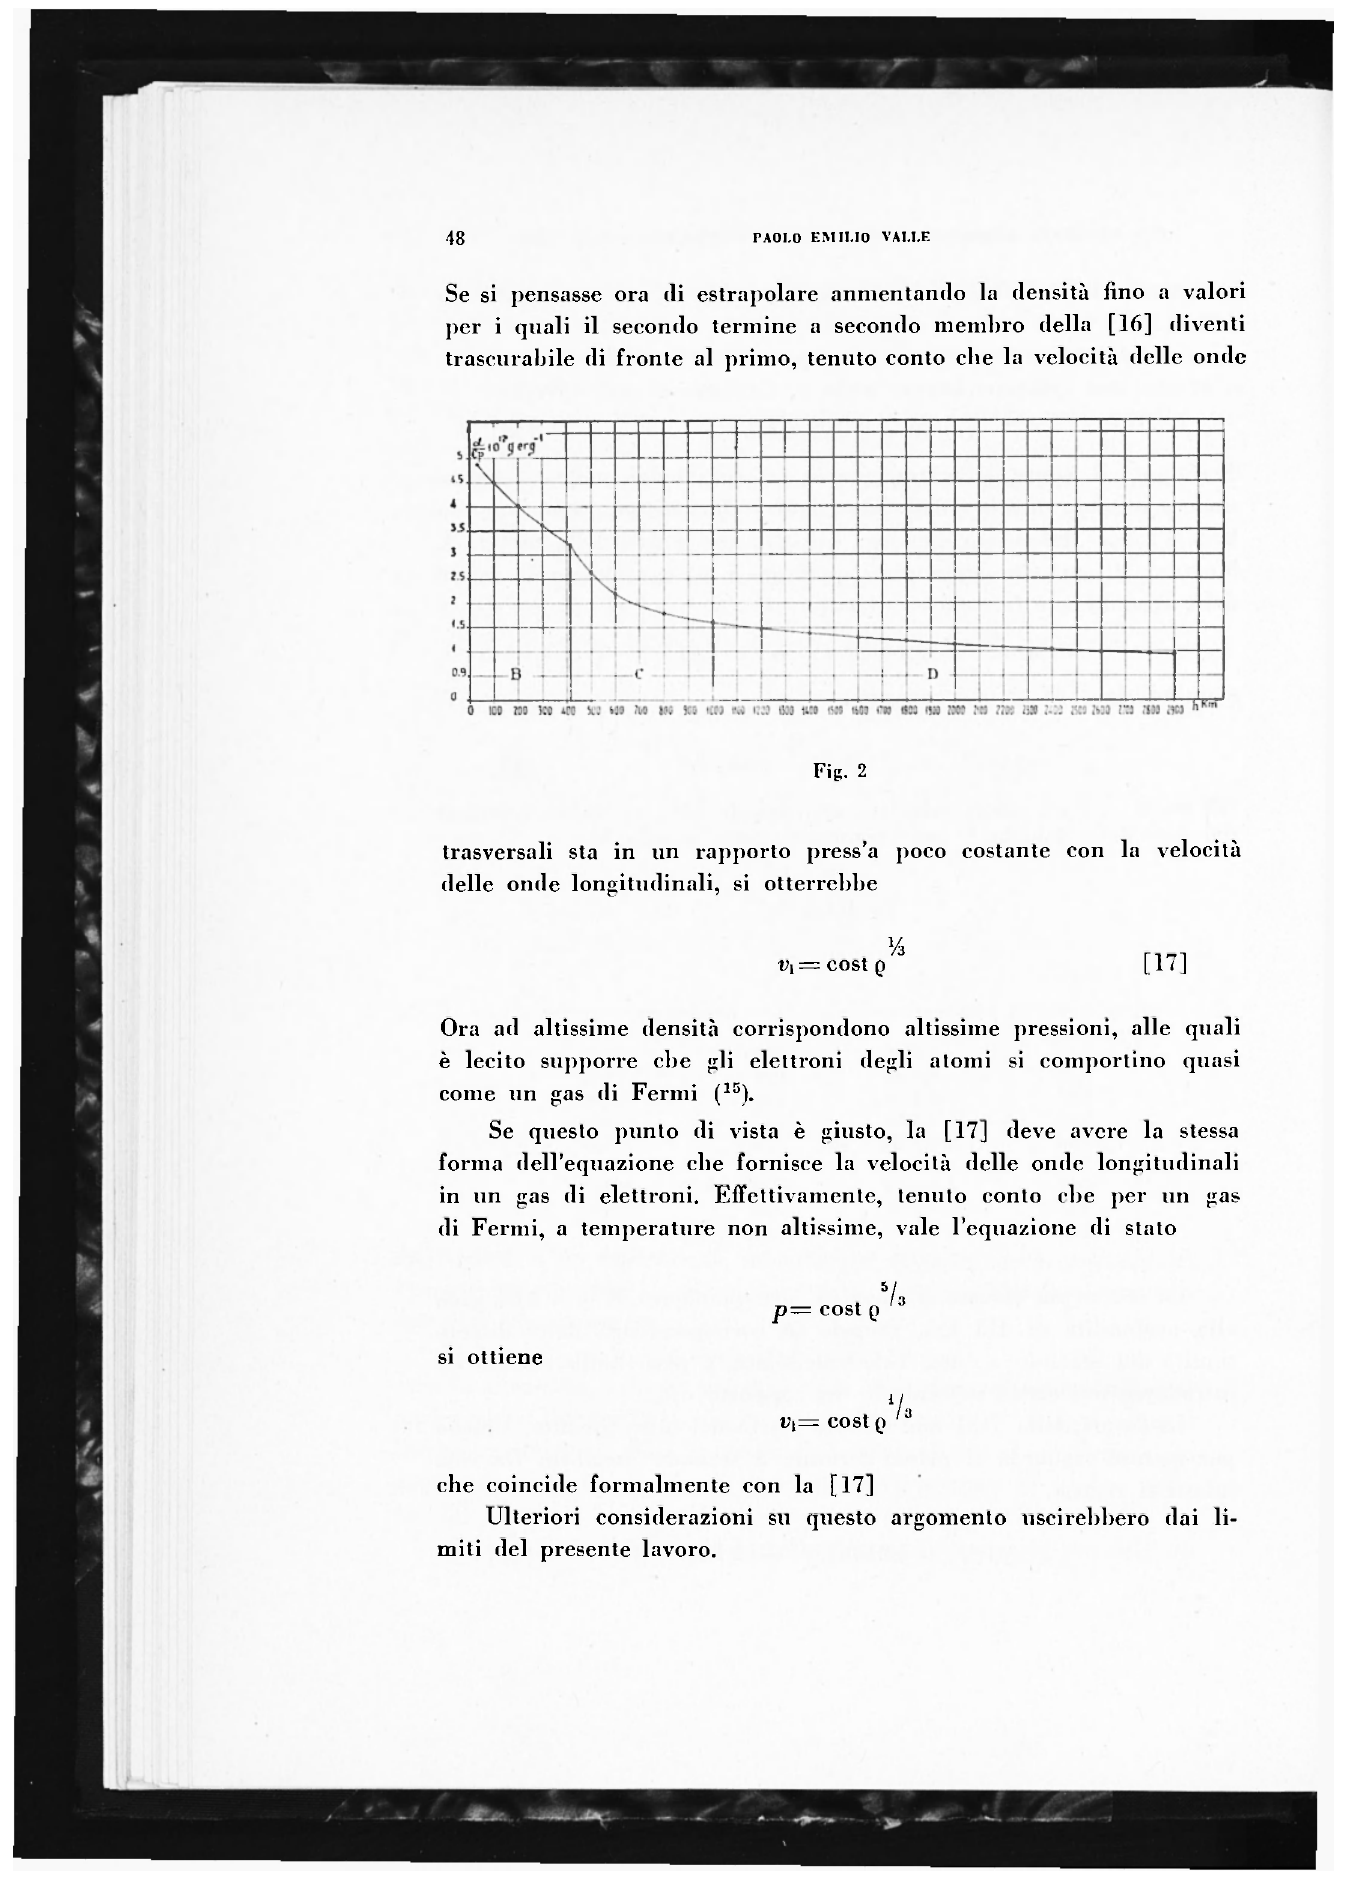
trasversali sta in un rapporto press'a poco costante con la velocità delle onde longitudinali, si otterrebbe